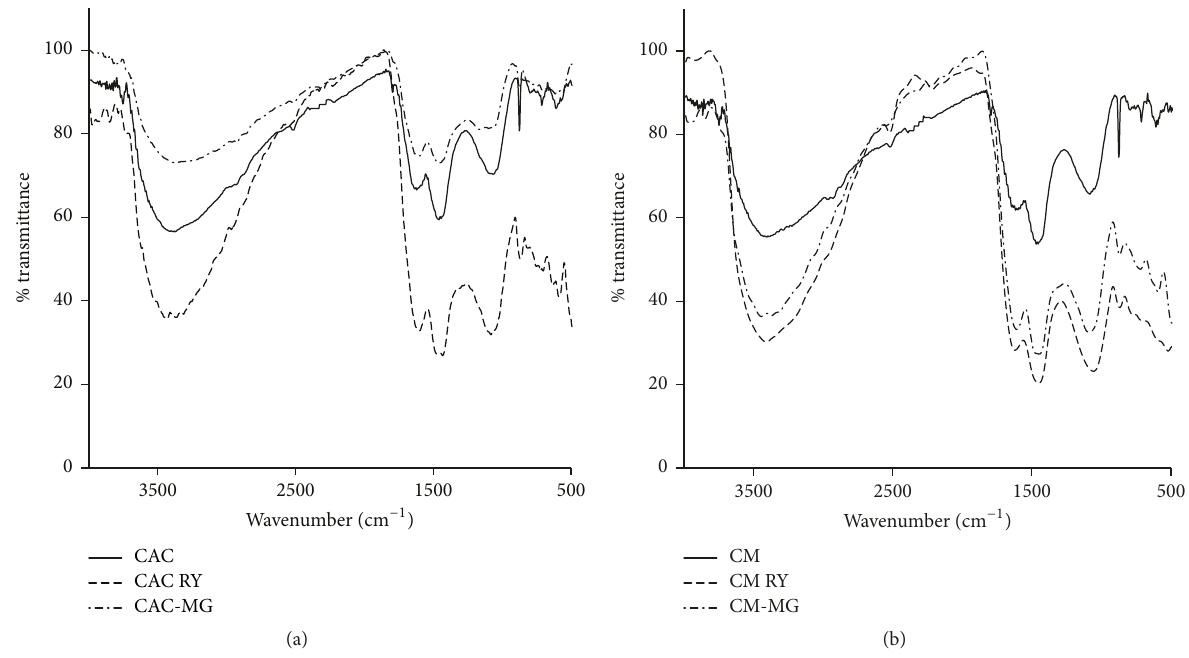
Figure 9: FT-IR characterization of (a) CAC and (b) CM before and after malachite green and Remazol yellow adsorption.